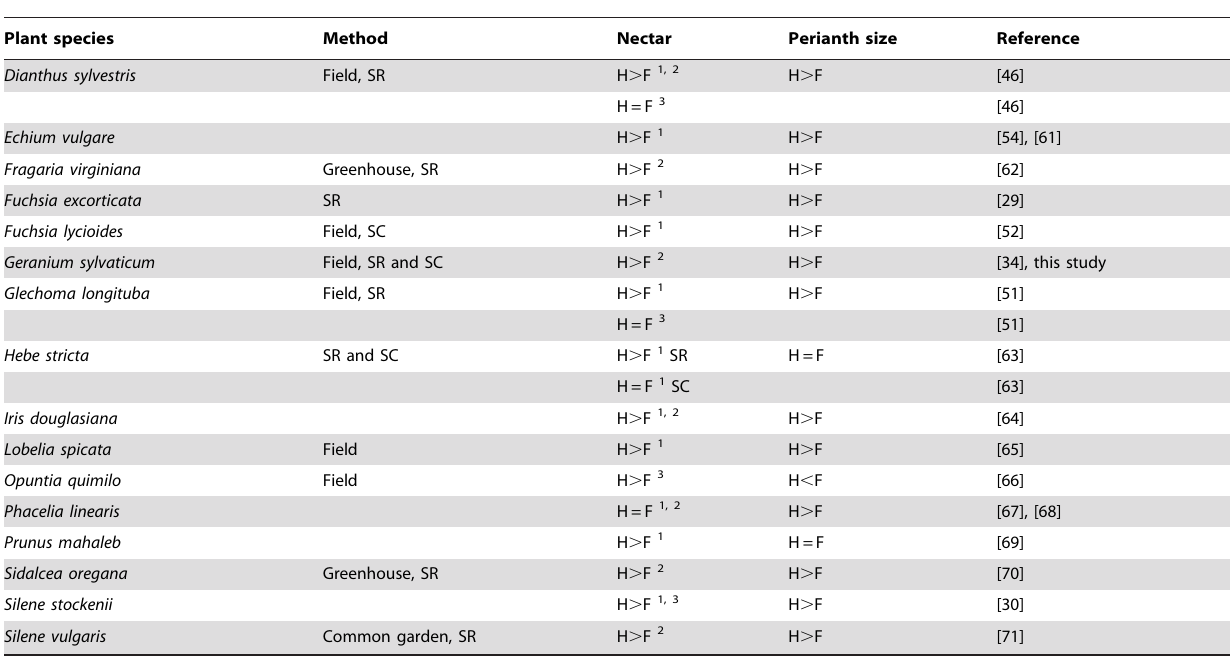
Table 1. Studies reporting nectar production in gynodioecious plants.